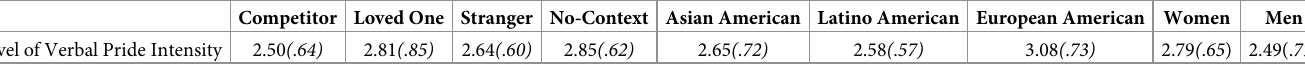
Table 1. Mean ( SD ) values for coder ratings of verbal pride intensity by social context, ethnic heritage, and gender. Competitor Loved One Stranger No-Context Asian American Latino American European American Women